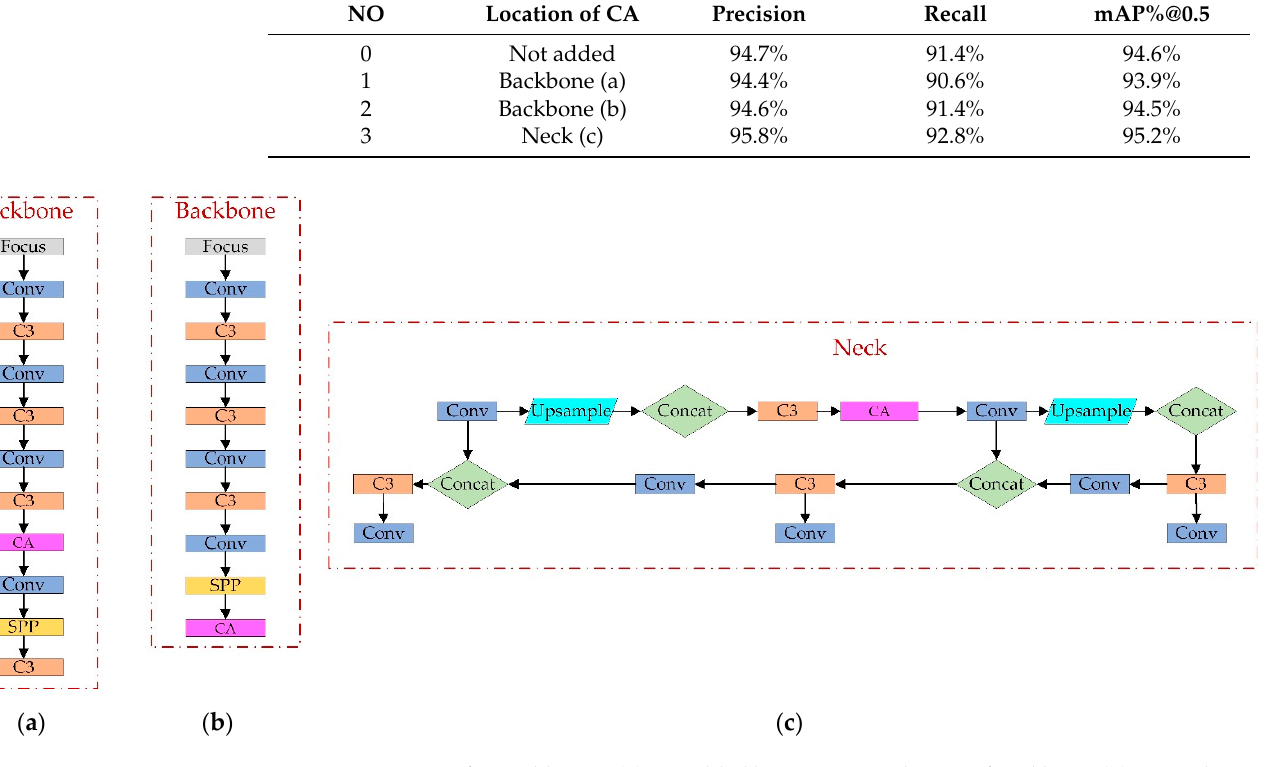
Figure 8. Location of CA additions. ( a ) CA added between C3 and Conv of Backbone; ( b ) CA re- places the last C3 layer of Backbone; ( c ) CA added between C3 and Conv of